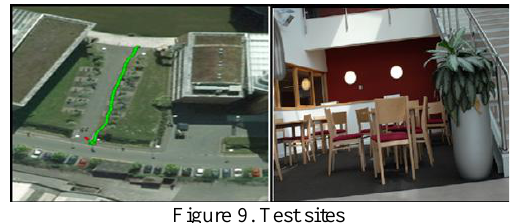
Figure 9. Test sites